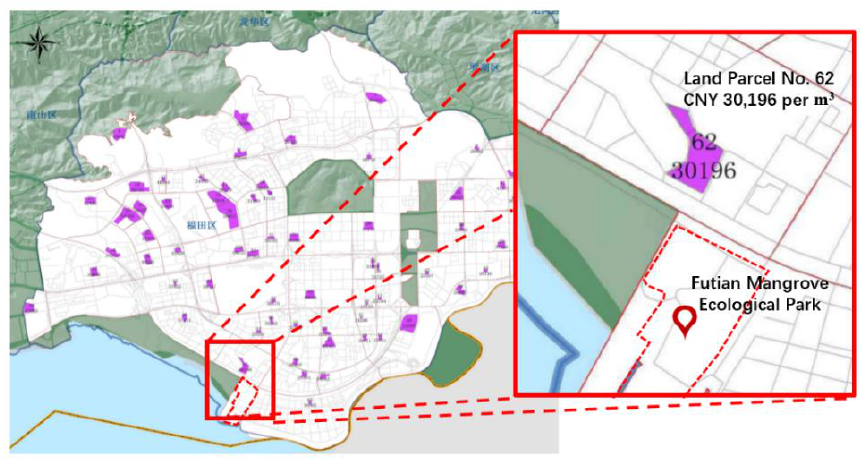
Figure 3. Price of residential land in Futian District, Shenzhen.